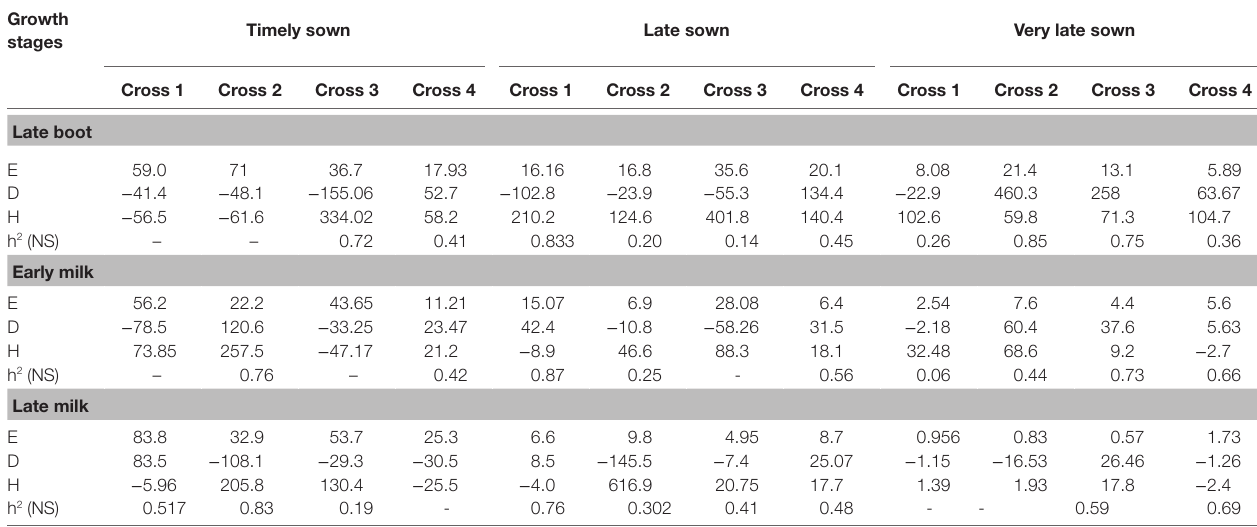
TABLE 8 | Estimates of variance components and narrow sense heritability for stomatal conductance in four crosses at three growth stages under timely, late, and very late sown condition. Growth Timely sown Late sown Very late stages